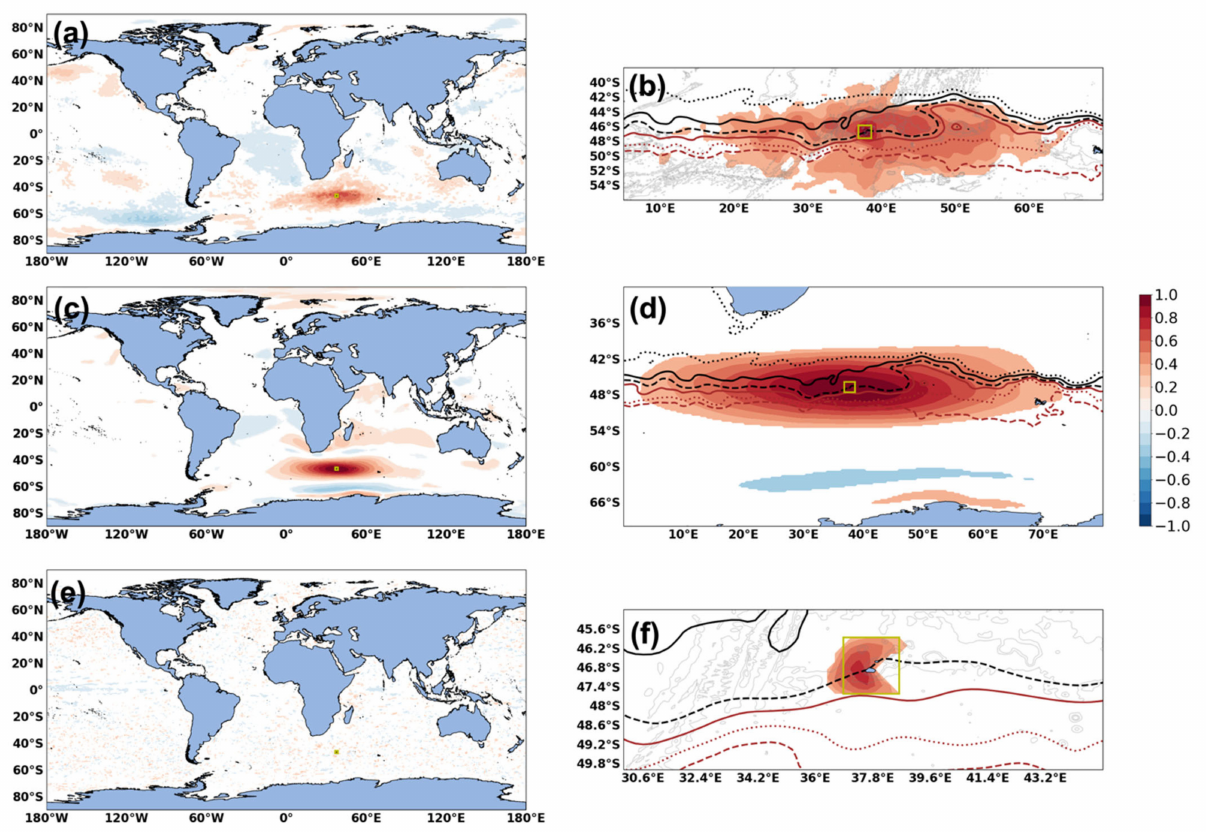
Figure 11. Maps of the significant correlation ( p -value < 0.05) between ( a ) Sea Surface Temperature (SST) anomalies at the Prince Edward Islands (PEIs) and the SST anomalies across the global ocean, ( c ) wind speed anomalies at the PEIs and across the global ocean, ( e ) geostrophic current speed anomalies at the PEIs and across the global ocean. The black box indicates the zoomed regions in panels b, d, and f. The zoomed maps show the regions of strong correlation ( − 0.3 < R > 0.3) for ( b ) SST anomalies, ( d ) wind speed anomalies, and ( f ) geostrophic current anomalies around the PEIs. The yellow box indicates the 2 ◦ × 2 ◦ area around the PEIs within which data were averaged for time series